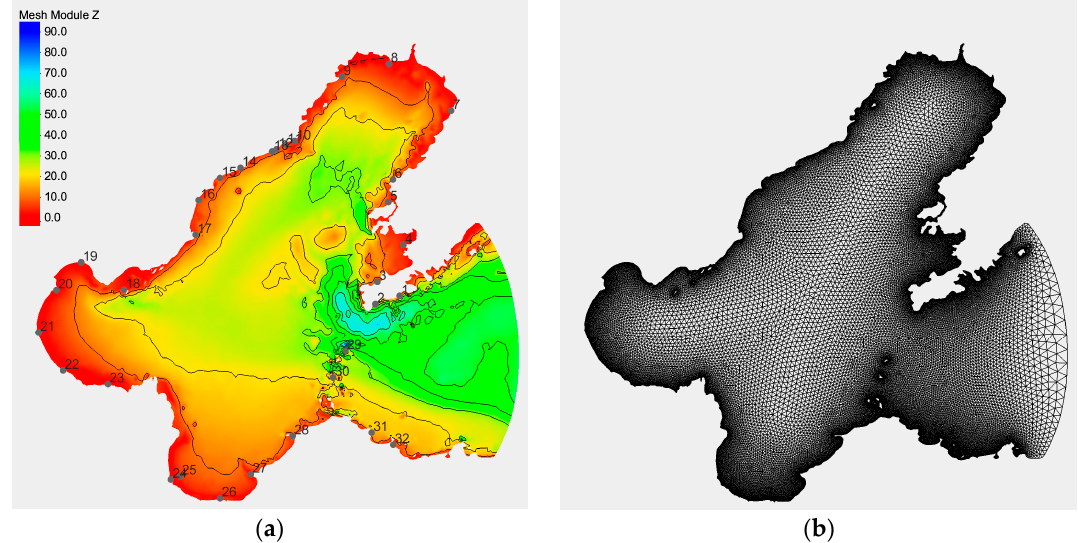
Figure 2. Bohai Sea model domain (the scale of the domain is about 450 km by 450 km). ( a ) Bathymetry (m) with colored contour and color bar, and 32 tidal stations (grey dots). ( b ) unstructured triangular mesh grid (26,002 nodes and 49,610 elements) with 500 m resolution near the shore.